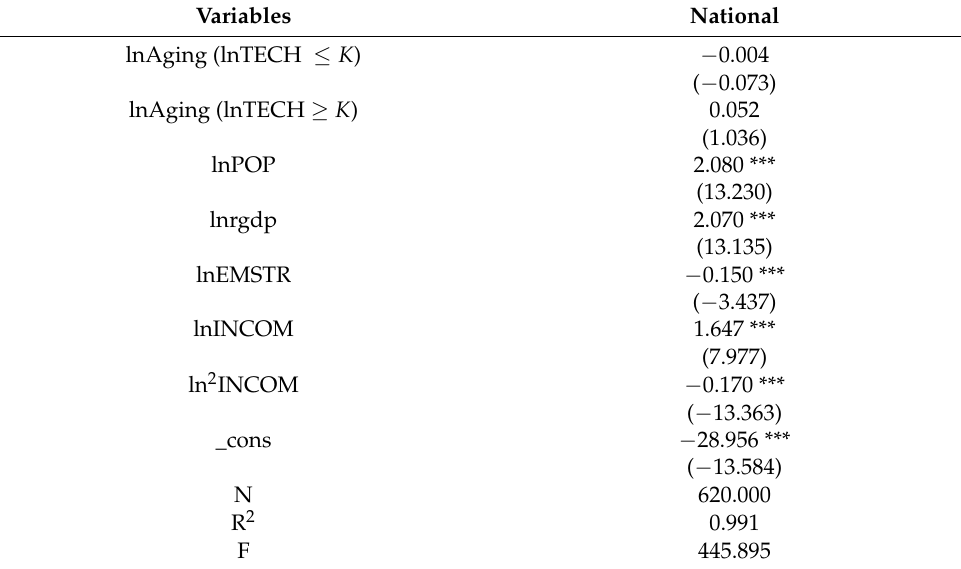
Table 10. Technological innovation threshold effect of population aging on carbon